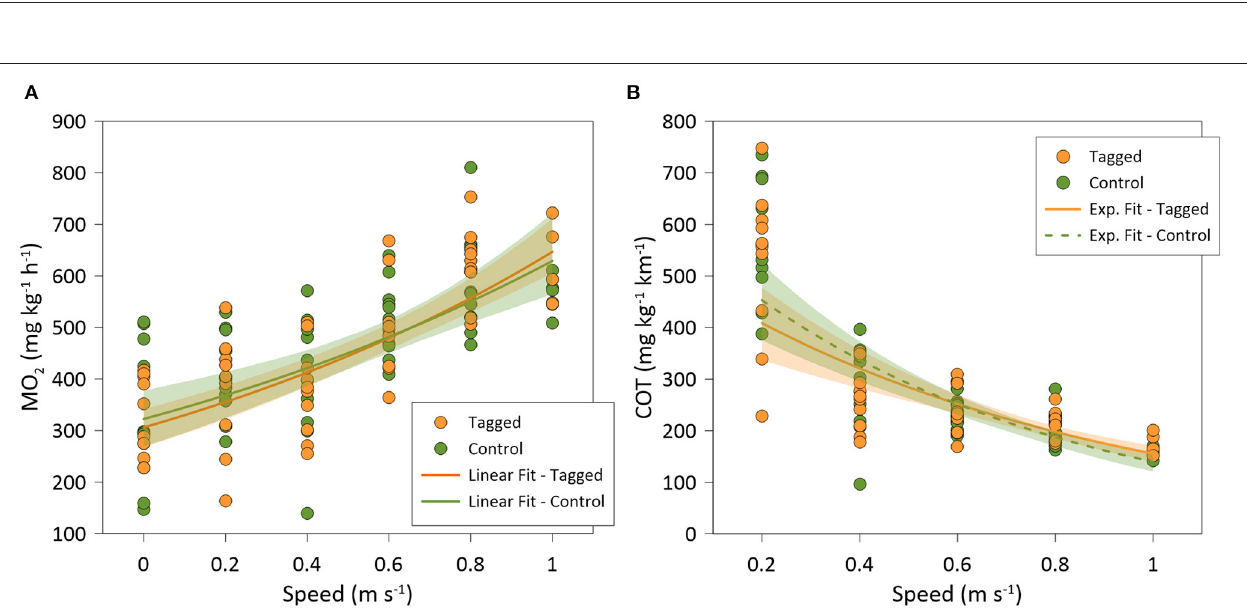
FIGURE 4 | (A) Best-fitted regression of: (A) oxygen consumption rates (MO 2 ); and (B) oxygen cost of transport (COT), of tagged (orange; N = 9) and control (green; N = 10) Sparus aurata in swim-tunnels at different swimming speeds.